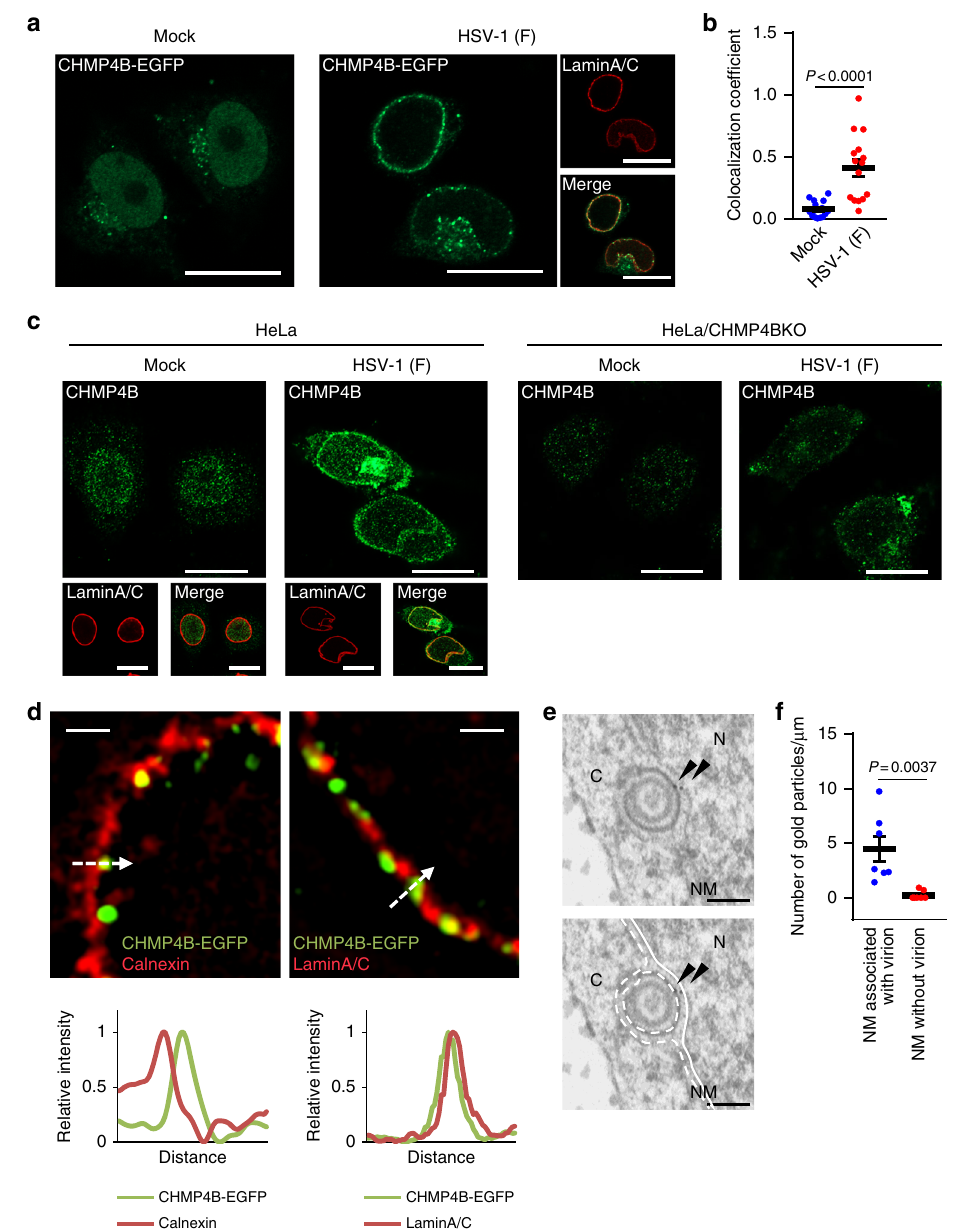
Fig. 1 ESCRT-III is recruited to the nuclear rim in HSV-1-infected cells. a HeLa/CHMP4B-EGFP cells mock-infected or infected with HSV-1 for 22 h were analyzed by confocal microscopy for CHMP4B-EGFP and lamin A/C. Bars, 20 μ m. Images are representative of three independent experiments. b Colocalization between CHMP4B-EGFP and lamin A/C in the experiment in ( a ) was quanti fi ed using Mander ’ s colocalization coef fi cient. Data are shown as the mean ± SEM ( n = 16 for mock-infected and 15 for HSV-1-infected cells representative of three independent experiments). c HeLa or HeLa/CHMP4B KO cells were mock-infected or infected with HSV-1 for 22 h and analyzed by confocal microscopy for CHMP4B and lamin A/C. Bars, 20 μ m. Images are representative of three independent experiments. d HeLa/CHMP4B-EGFP cells infected with HSV-1 for 22 h were analyzed by N-SIM super-resolution microscopy for (left) CHMP4B-EGFP and calnexin or (right) CHMP4B-EGFP and lamin A/C. Bars, 1 μ m. Fluorescence line scans along the dotted lines of N- SIM images are shown under each image. Images are representative of three independent experiments. e HeLa/CHMP4B-EGFP cells were infected with HSV-1 for 24 h and analyzed by immunoelectron microscopy. C cytoplasm, N nucleus, NM, nuclear membrane. Bars, 200 nm. Arrowheads indicate localization of CHMP4P-EGFP labeled with anti-GFP antibody along the INM and in primary enveloped virions. In the lower panel, straight lines indicate the INM and dotted lines indicate the ONM and the envelope of virions in the perinuclear space. Images are representative of three independent experiments. f Quanti fi cation of gold particles on the NM with or without virions in the experiment in ( e ). Seven areas of each section were analyzed and the data are shown as the mean ± SEM. Data are representative of two independent experiments. The indicated P -values were obtained using the unpaired Student ’ s t - test ( b , f